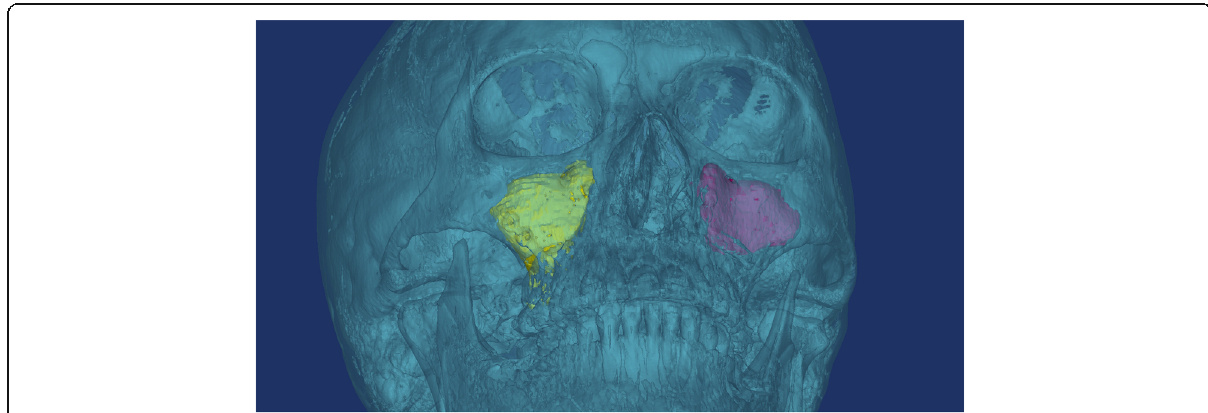
Fig. 3 3D reconstruction of the maxillary sinus showing haziness, determined by subtracting the empty space (e.g., red left maxilla) volume of the maxillary sinus from the total maxillary sinus volume (e.g., yellow in the right maxilla) in each maxillary sinus after surgery